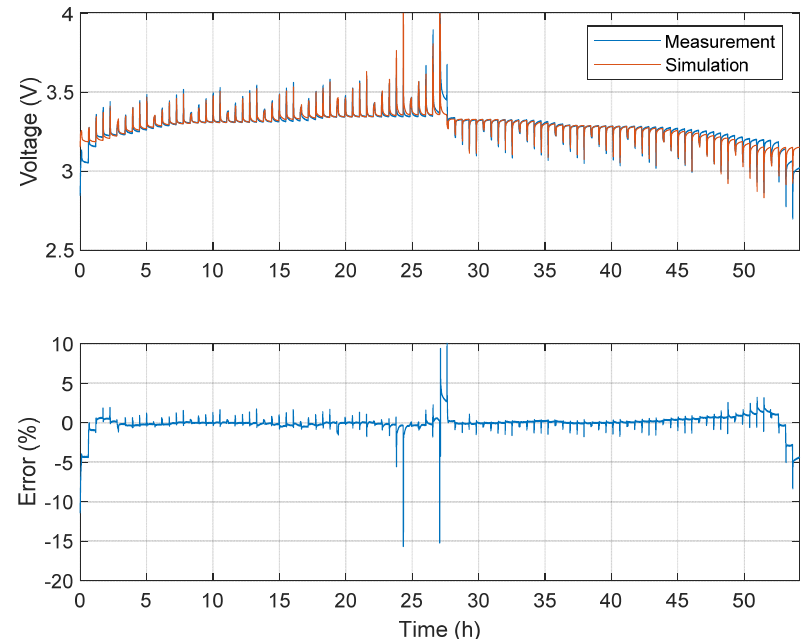
Figure 11. Lithium-ion battery parameter extraction test voltage response.